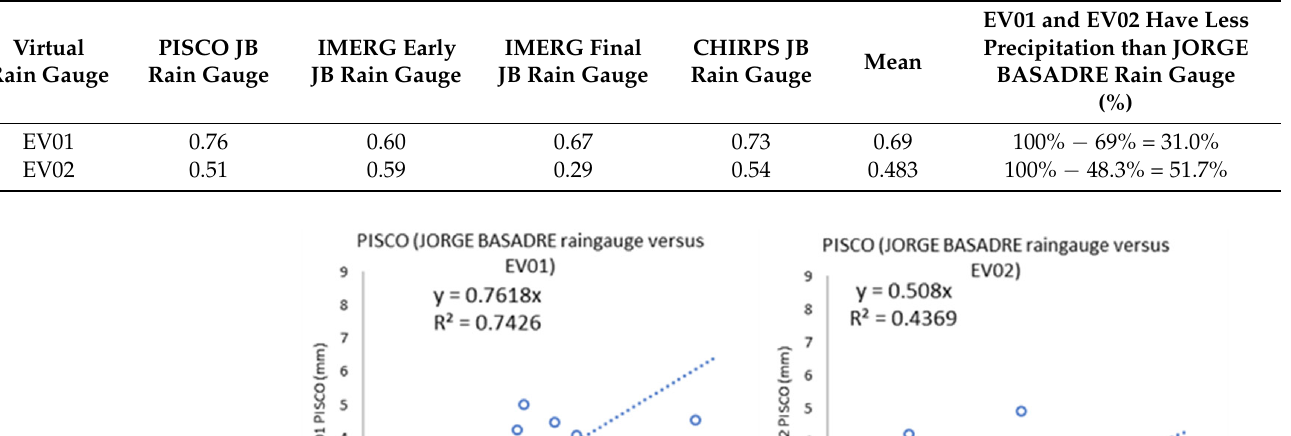
Table 4. Summary of the regression coefficients and percentage between the JORGE BASADRE rain gauge and the virtual rain gauge (EV01 and EV02).